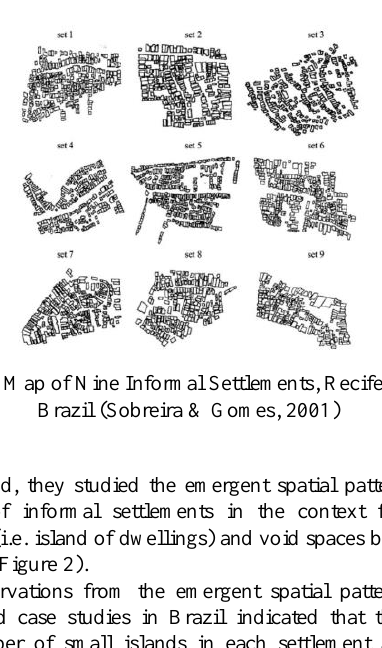
islands of isolated dwellings (Figure 3